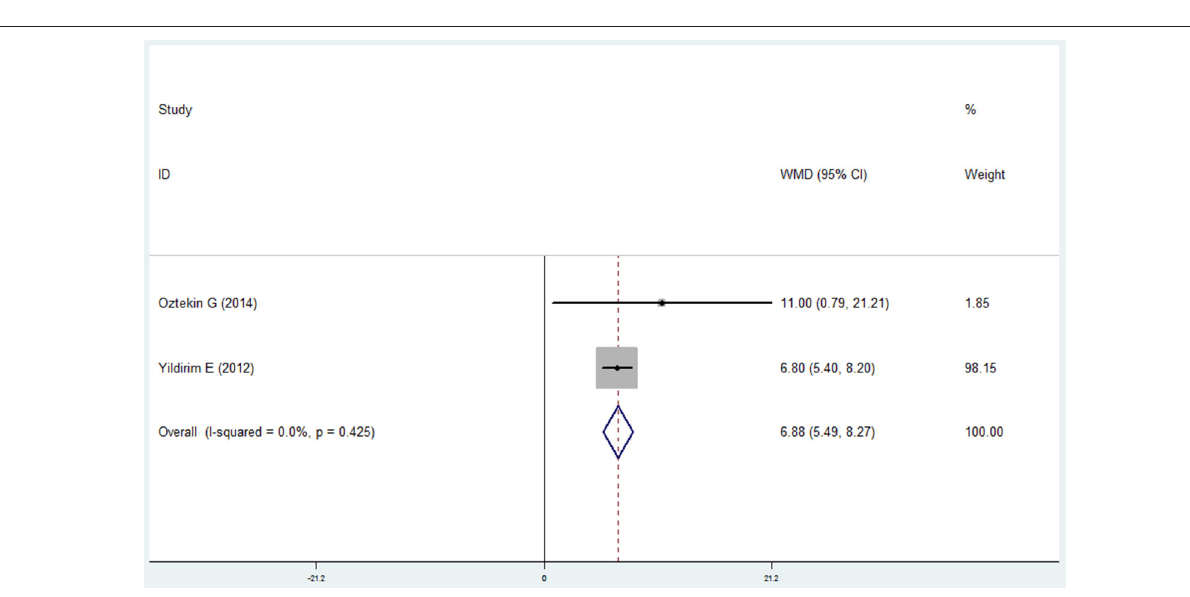
FIGURE 8 | Forest plot of the mean difference in bleeding on probing between the COPD and non-COPD